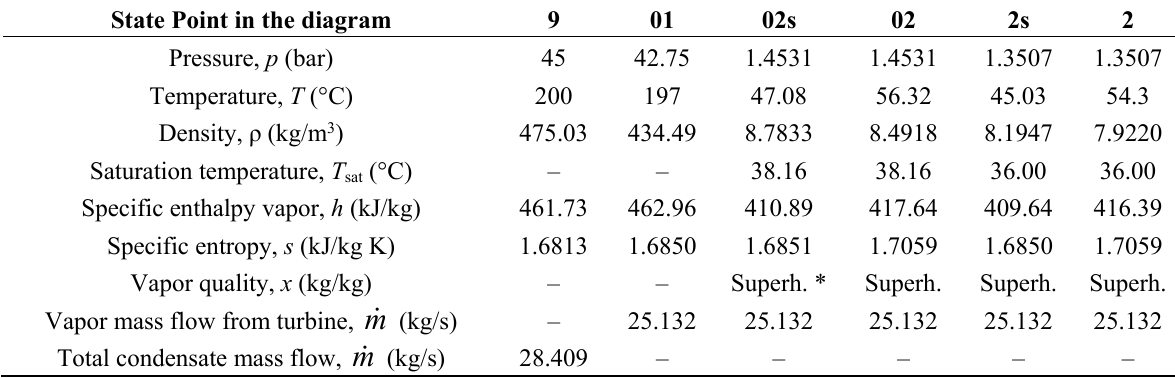
Table 6. R123 vapor state points before and after turbine; repeated calculation.